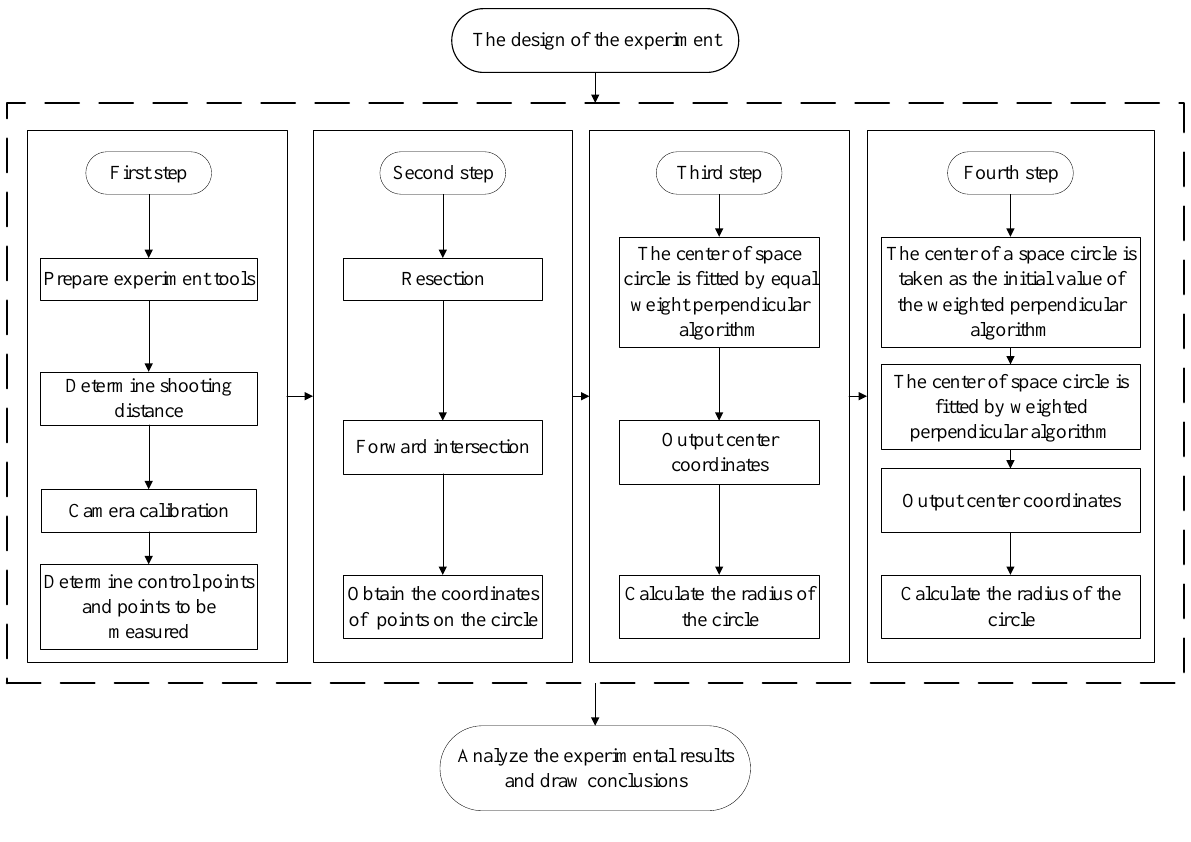
Figure 4. Flowchart of